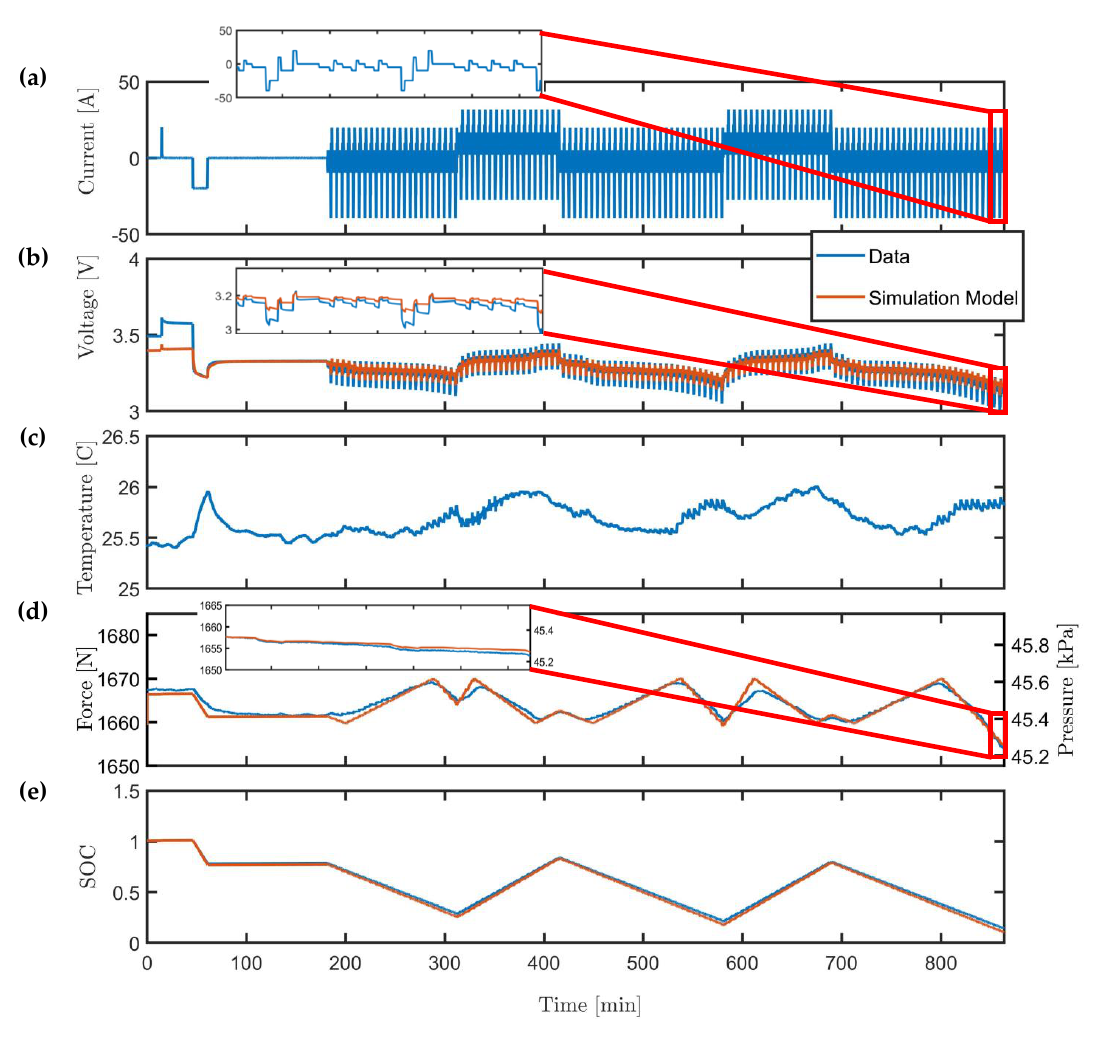
Figure 4. Comparison of open loop simulation model results (denoted by the color orange) and experimental measurement of voltage, temperature, force, and SOC obtained from the 20 Ah battery during the Dynamic Stress Test (DST) inside an environmentally controlled chamber set at 25 ◦ C ambient conditions. ( a ) Current profile scaled for the 20 Ah A123 battery. ( b ) Comparison of the open loop model terminal voltage and measurement. ( c ) Measured battery temperature. ( d ) Comparison of the open loop modeled force and measured force. After 30 min of rest, the un-modeled dynamics in force excited by cycling of the cell to decay to zero. For generalization of the results to the other cell sizes, the pressure is shown. ( e ) Comparison of state of charge (SOC)